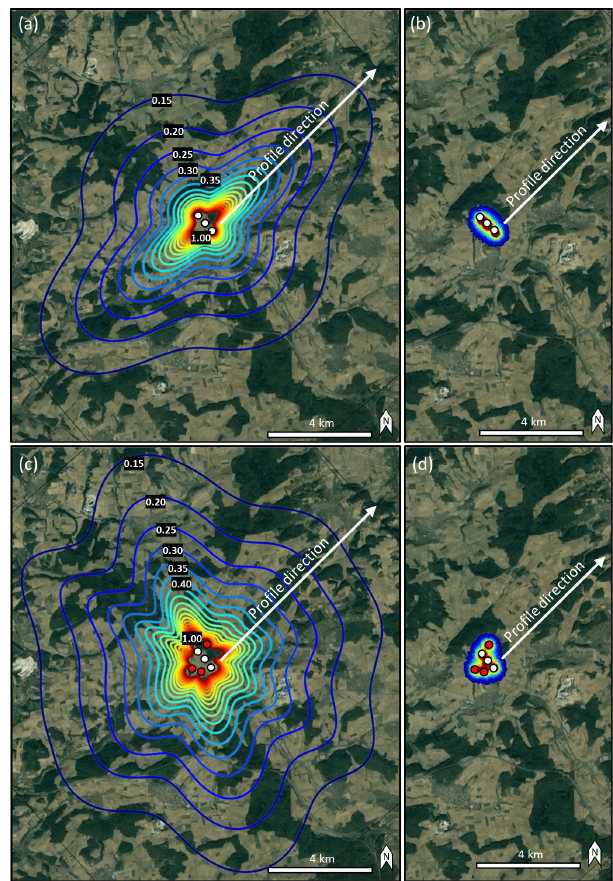
Figure 14. Estimated seismic radiation pattern (red showing high amplitudes) of (a) the Uettingen wind farm (white dots) for 1.14Hz and (b) 7.6Hz. Three arbitrary WTs (red dots) are added to the ex- isting WF and affect the radiation for (c) 1.14Hz and (d) 7.6Hz. Model parameters are c S = 960ms − 1 and Q S = 40 in (a, c) , whereas they are c S = 540ms − 1 and Q S = 16 in (b, d) . Calcu- lations are based on 500 averaged wave fields using random source signal phases. Contour lines show the amplitude decay factor from 1 to 0.15 (map data: ©Google Maps,